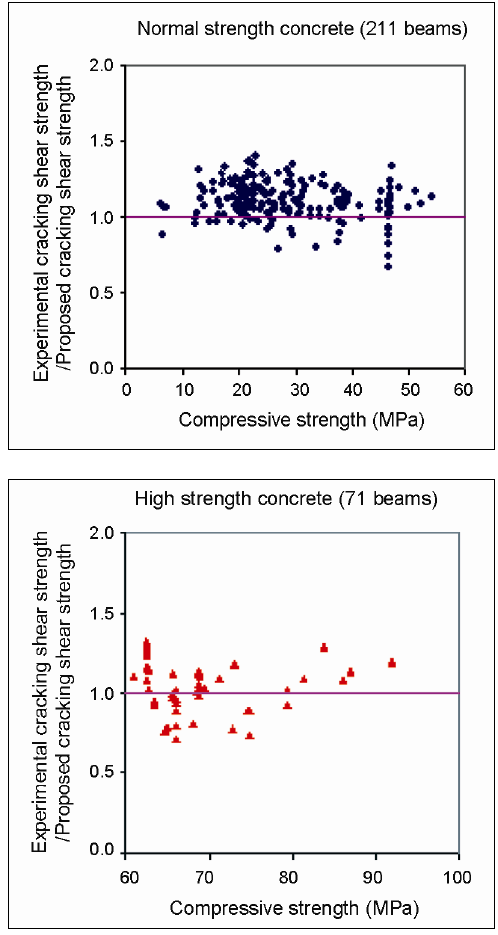
Fig. 5. Comparing experimental cracking shear strength values with proposed diagonal cracking strength of Eq. (12) for various flexural reinforcement ratios